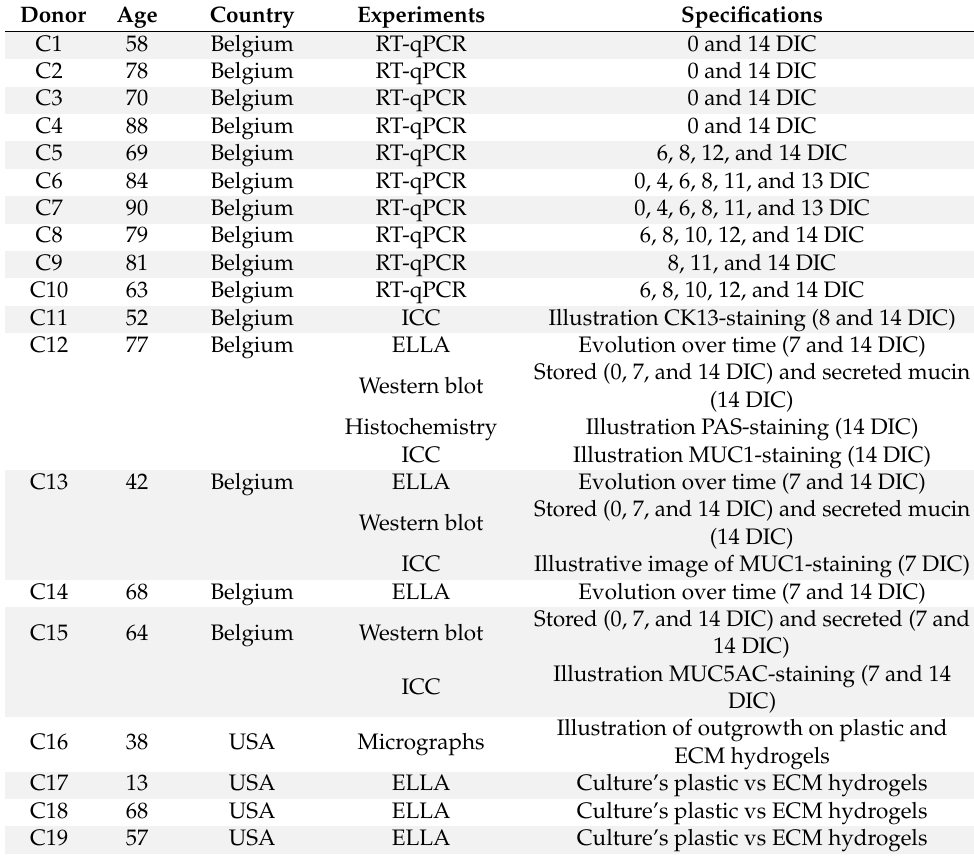
Table 1. Donor characteristics and experimental